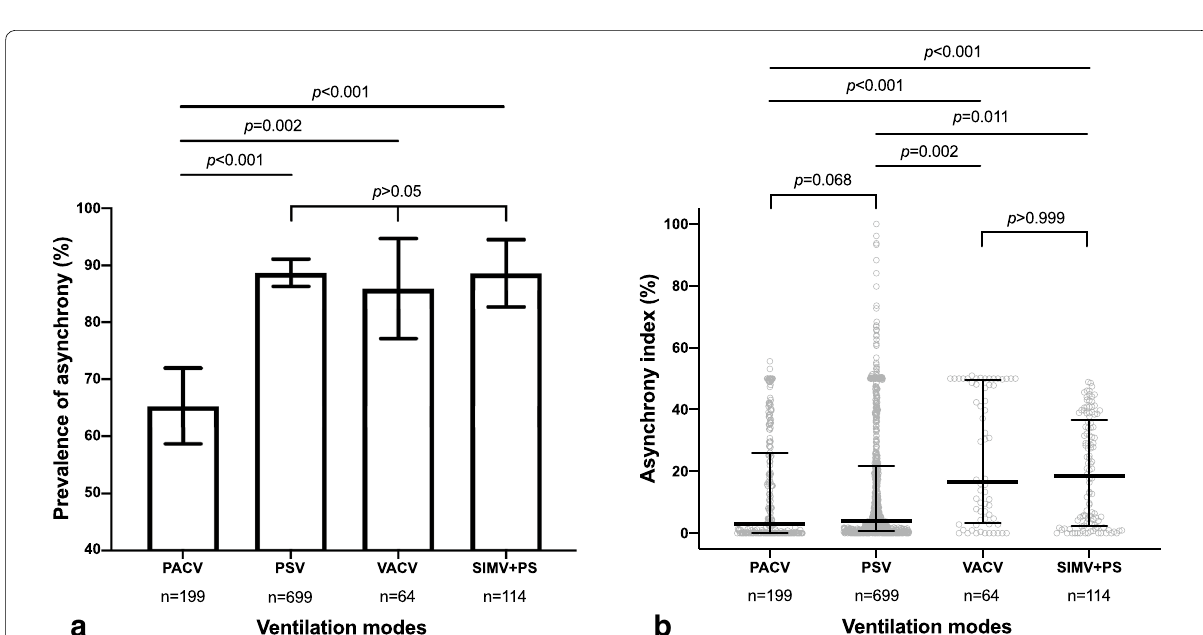
Fig. 3 No significant difference was found in asynchrony index among the three classifications of brain injury ( p data, median, and interquartile ranges are shown. The median (interquartile range) asynchrony index was 13.5% (3.3%–35.3%), 9.5% (3.5%–20.6%), and 16.8% (11.7%–39.5%) in patients with stroke, post‑craniotomy for brain tumor, and traumatic brain injury, respectively